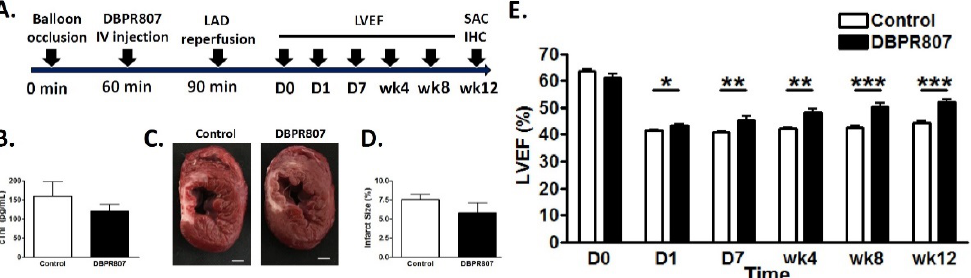
Figure 5. DBPR807 treatment recovers cardiac function after IR injury in the mini-pig myocardial infarction model. ( A ) Mini-pigs were treated with or without DBPR807 (3 mg/kg, IV) prior to balloon-induced IR injury ( n = 10 per group) following the above experimental protocol. ( B ) Concentration of troponin I in blood after 24 h. ( C ) TTC staining after 12 weeks: viable tissue is red, and the infarct area is white; scale bar = 5 mm. ( D ) Infarct size was determined by the infarct area/LV area ratio and quantified as a percentage after 12 weeks. ( E ) Changes in LVEF (control vs. DBPR807) from D0 to 12 weeks were measured. The data are presented as mean ± SEM. Statistical analysis was performed by t -test: * p < 0.05, ** p < 0.01 and *** p < 0.001.